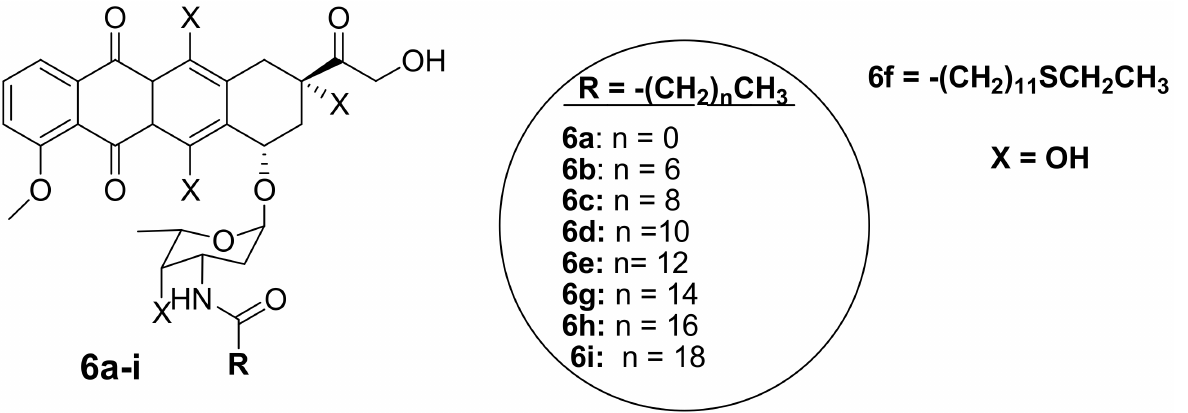
Figure 3. Chemical structures of doxorubicin-fatty acyl derivatives synthesized via the amino group ( 6a – i